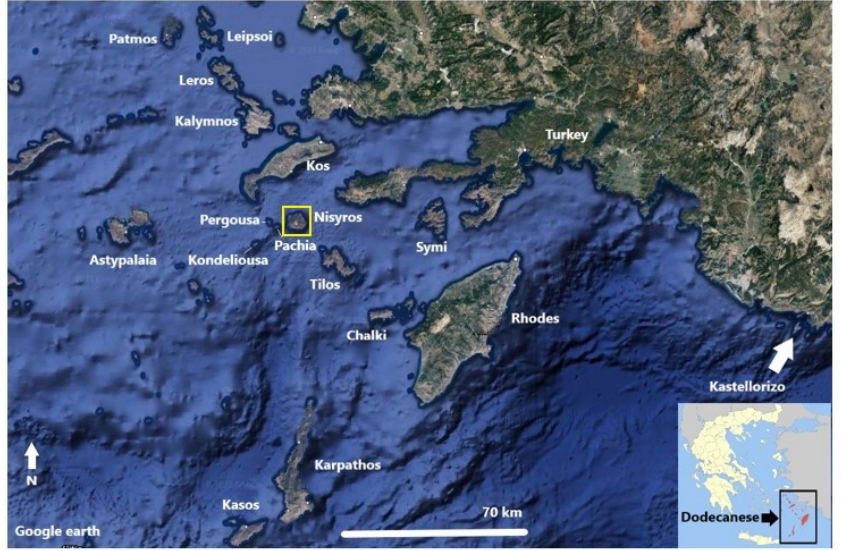
Figure 2. Satellite photo of the Dodecanese island complex, SE Greece, indicating the location of Nisyros Island; Inlet: Sketch map of Greece indicating the location of Dodecanese island complex.